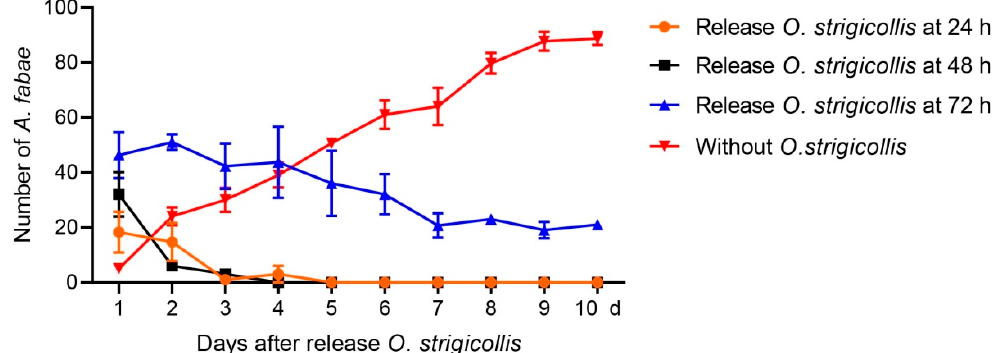
Figure 2. Number of surviving Aphis fabae in different treatments after the release of Orius strigicollis adults. Five Orius adults were introduced when the aphids had been feeding and reproducing on faba bean seedlings for 24, 48, and 72 h, and the treatment of aphids without release of Orius was used as control. Numbers of A. fabae were counted daily for 10 days.